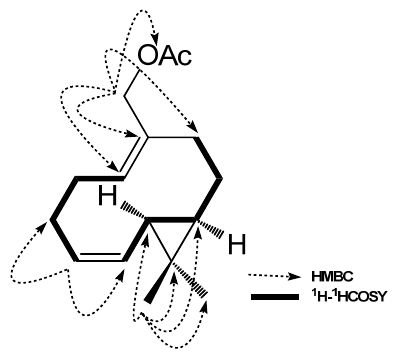
Figure 4. NOE correlations of compounds 1 – 3